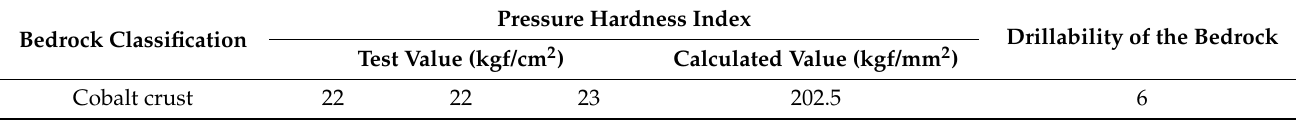
Figure 3. Deep sea cobalt crust samples and the bedrock hardness testing apparatus. Table 2. Indentation hardnesses and drillability classification of the